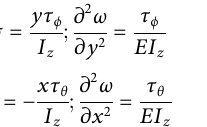
The model (4) is proposed to characterize the torsion of the TABLE 1 Analysis of the maximum deformations ( ω max , roll , ω max , pitch ) in the fl exible UAV due to bending loads for changes in the in fi ll rate UAV (with the constants A = 53.83, B = − 14.48, C = 1.02, D = ρ τ ϕ and τ θ tpu and the applied torques 2.86, and E = 1.11), whose physical meaning can be interpreted in ρ Figure 4. Note that as the fl exibility of the material increases, the tpu in fl uence of torsion becomes more evident. On the other hand, bending-type loads and deformations appear fundamentally during the roll and pitch maneuvers of the UAV (with respect to the main and secondary axes, x and y, in each case). The physical interpretation of these elastic effects can be observed in Figure 4, while an analytical approximation can be obtained using the Euler-Bernouille theory for roll (5) and pitch (6), respectively.